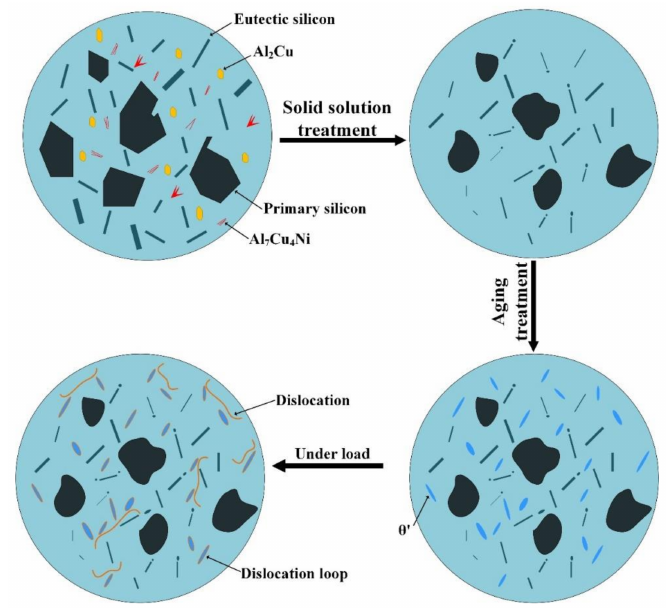
Figure 8. Effect of T6 heat treatment and Orowan strengthening